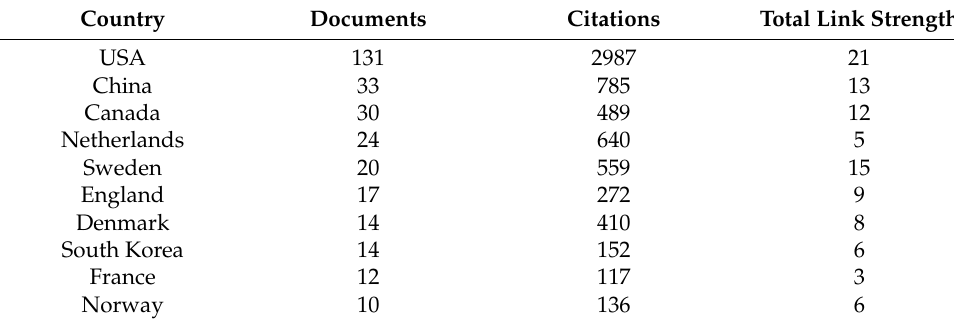
Table 1. Country analysis (descending order according to documents).